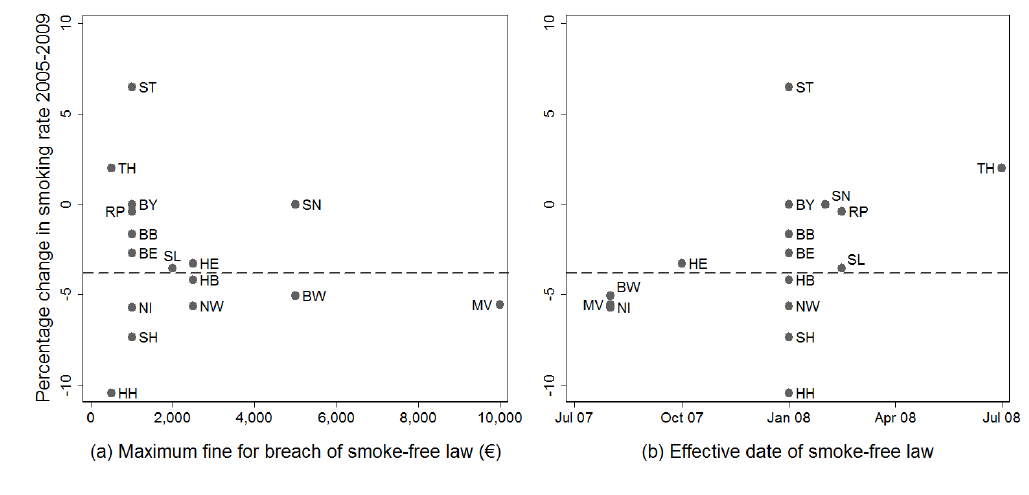
Figure 1. Maximum fine for a breach of the smoke-free law, effective date of the smoke- free law and change in smoking rate in German